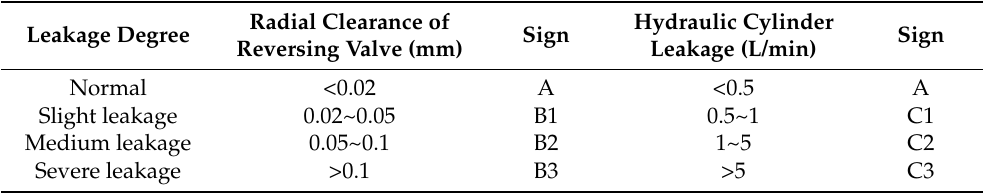
Table 9. Leakage fault of hydraulic system.